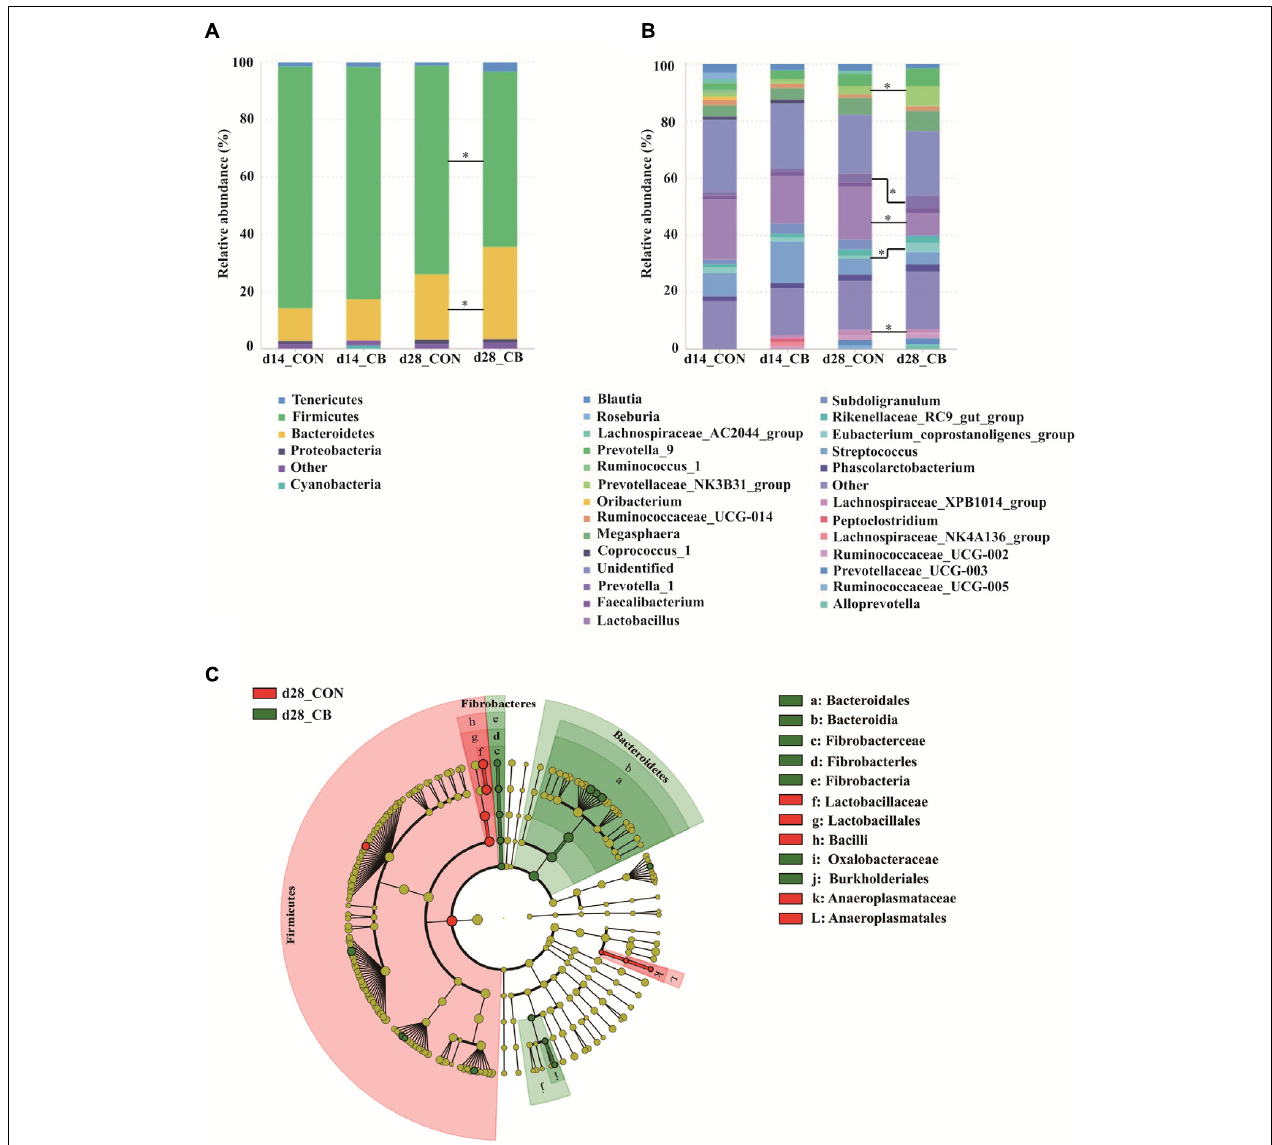
FIGURE 2 | Effects of dietary corn bran on microbial community structure in weaned pigs. (A) Microbial community barplot at the phylum level on days 14 and 28. (B) Microbial community barplot at the genus level on days 14 and 28. (C) Cladogram of LEfSe demonstrates taxonomic profiling for the distinct bacteria with significant higher abundances on day 28. The circle from inner to outer represents the different levels of bacteria members ranged from phylum to genus. Gut microbiota composition in feces ( n = 6 per treatment) were determined by 16S rRNA amplicon sequencing on the trial of days 14 and 28. The results were analyzed by wilcoxon rank-sum test and presented as mean relative abundance, and one asterisk means p < 0.05. CON, control group; CB, corn bran group; LEfSe, linear discriminant analysis effect